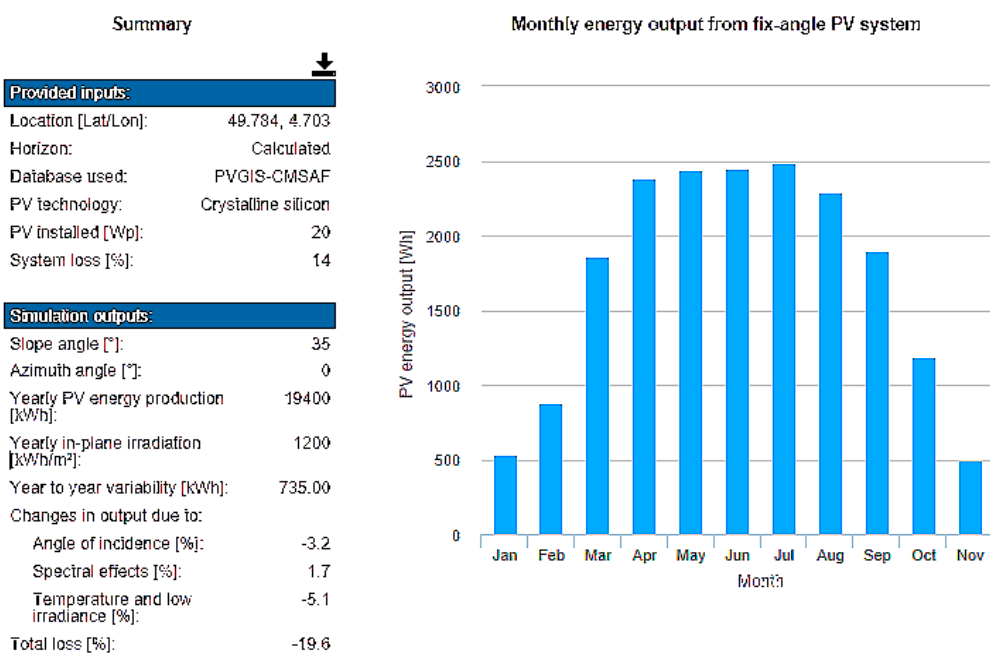
Figure 6. Monthly energy captured by a 20W solar panel installed in the North of France simulation, from the European Commission PVGIS. [27].